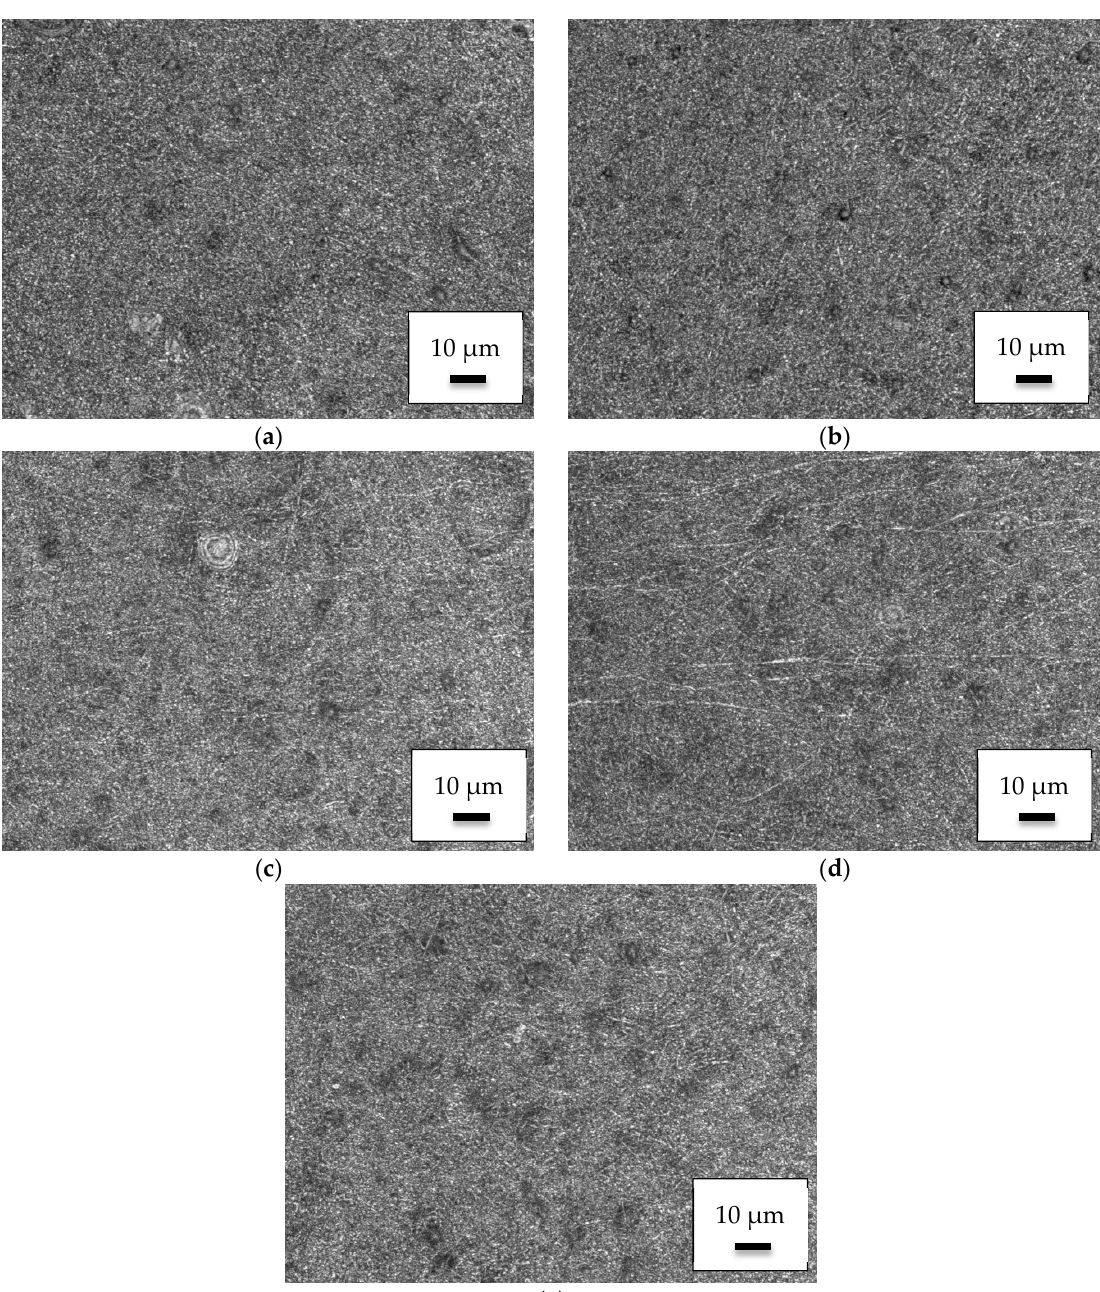
Figure 1. Confocal laser scanning microscope (CLSM) images of electrospun polyacrylonitrile (PAN) nanofiber mats with different spinning parameters (electrode-substrate distance/voltage): ( a ) 120 mm/70 kV; ( b ) 180 mm/60 kV; ( c ) 180 mm/70 kV; ( d ) 240 mm/70 kV; ( e ) 240 mm/80 kV. All spinning durations were 30 min.